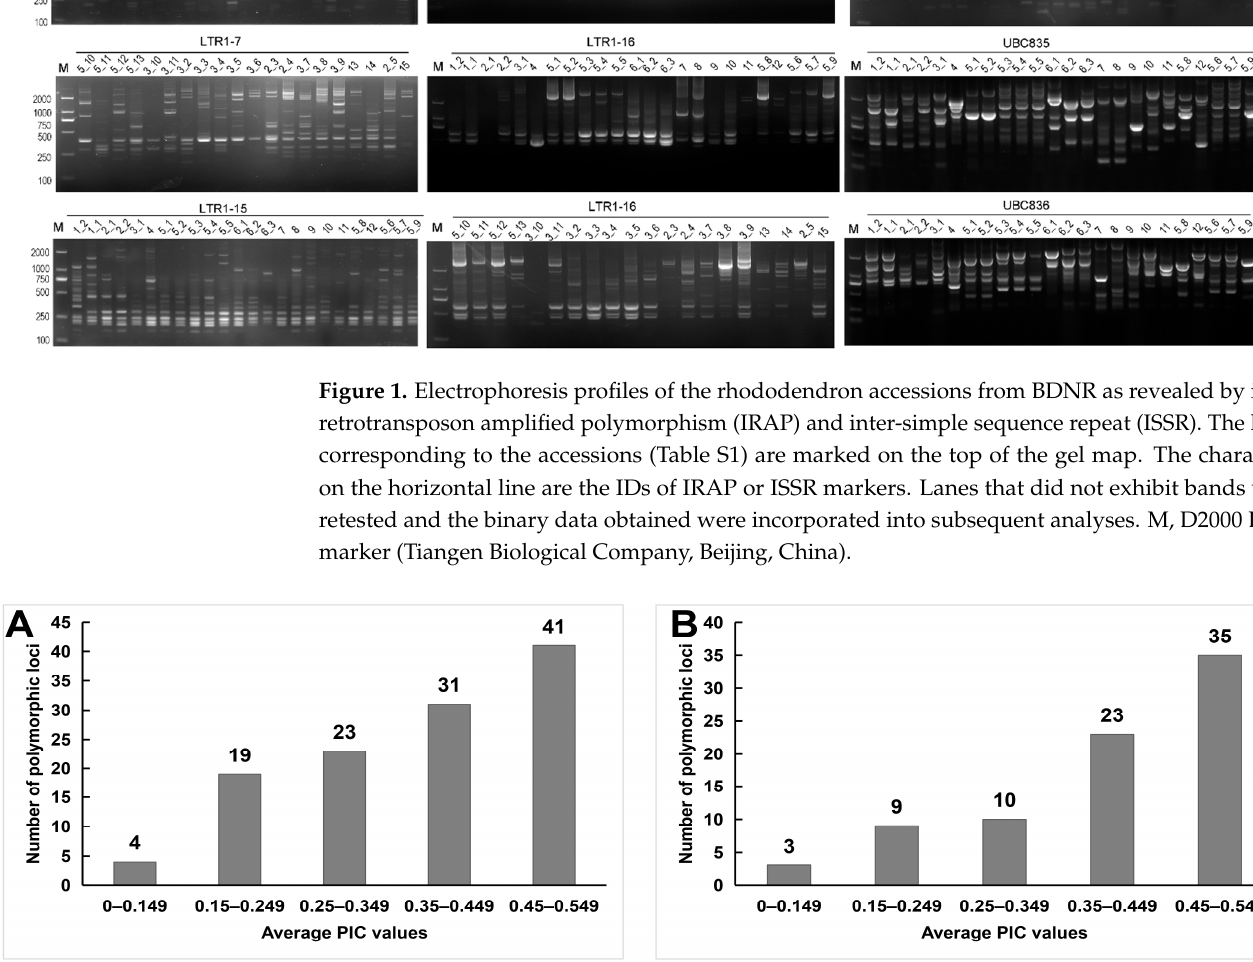
Figure 2. Distribution of average PICs from IRAP ( A ) and ISSR ( B ) markers among 46 rhododendron accessions.